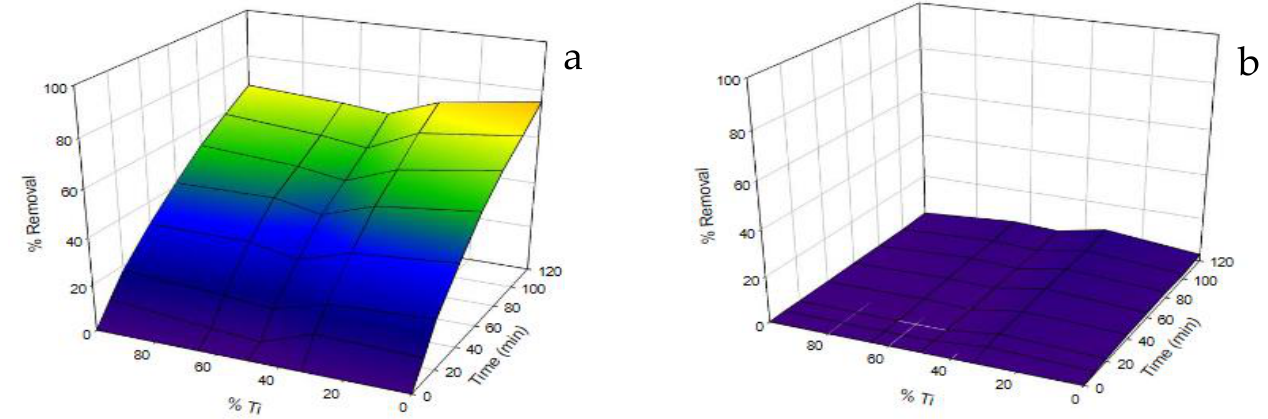
Figure 9. Three-dimensional curves of removal of 400 ppm ions with 10 ppm dye in the presence and absence of UV irradiation: ( a ) under UV irradiation; ( b ) without UV irradiation.